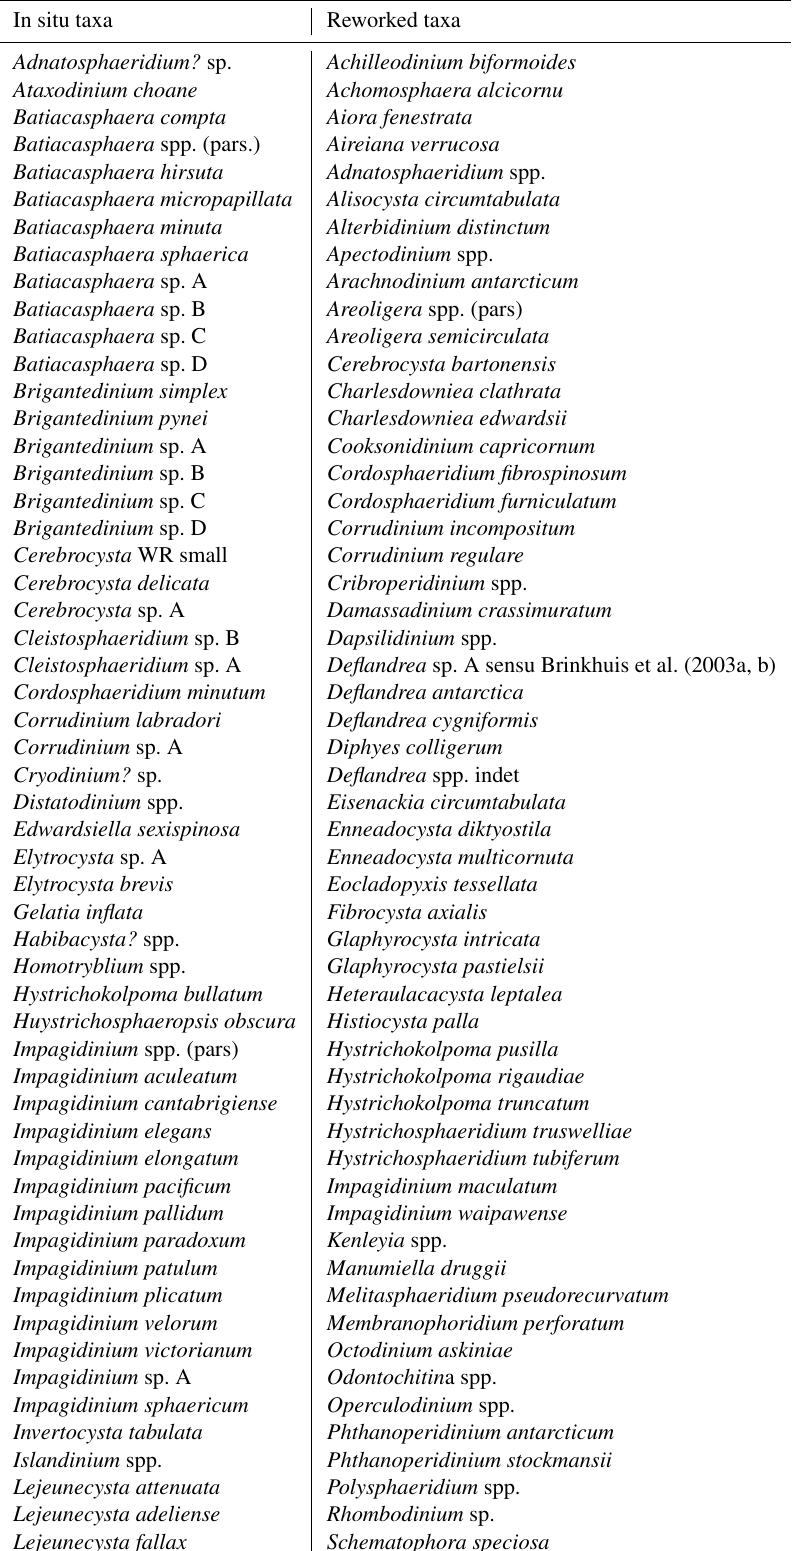
Table 2. List of assumed in situ and reworked dinoflagellate cyst taxa encountered in this study. See Bijl et al. (2018a) for informal species descriptions and discussion about which species are considered reworked and in